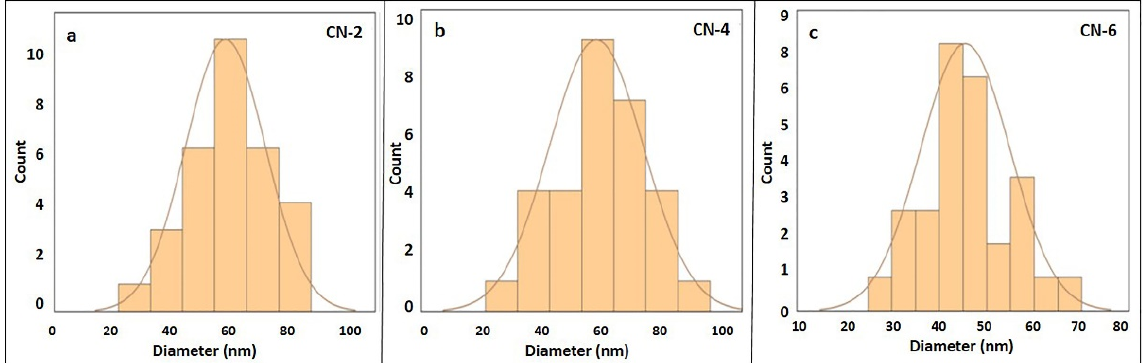
Figure 12. Nanocrystals’ diameter distribution curves of ( a ) CN-2, ( b ) CN-4, and ( c ) CN-6 samples.